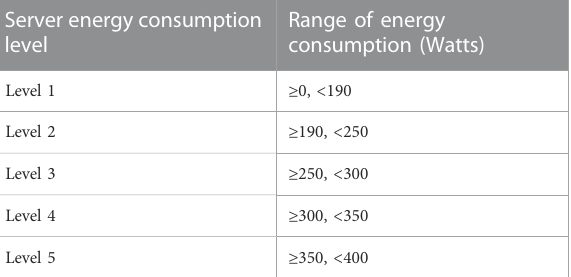
TABLE 4 Server energy consumption level and corresponding range.